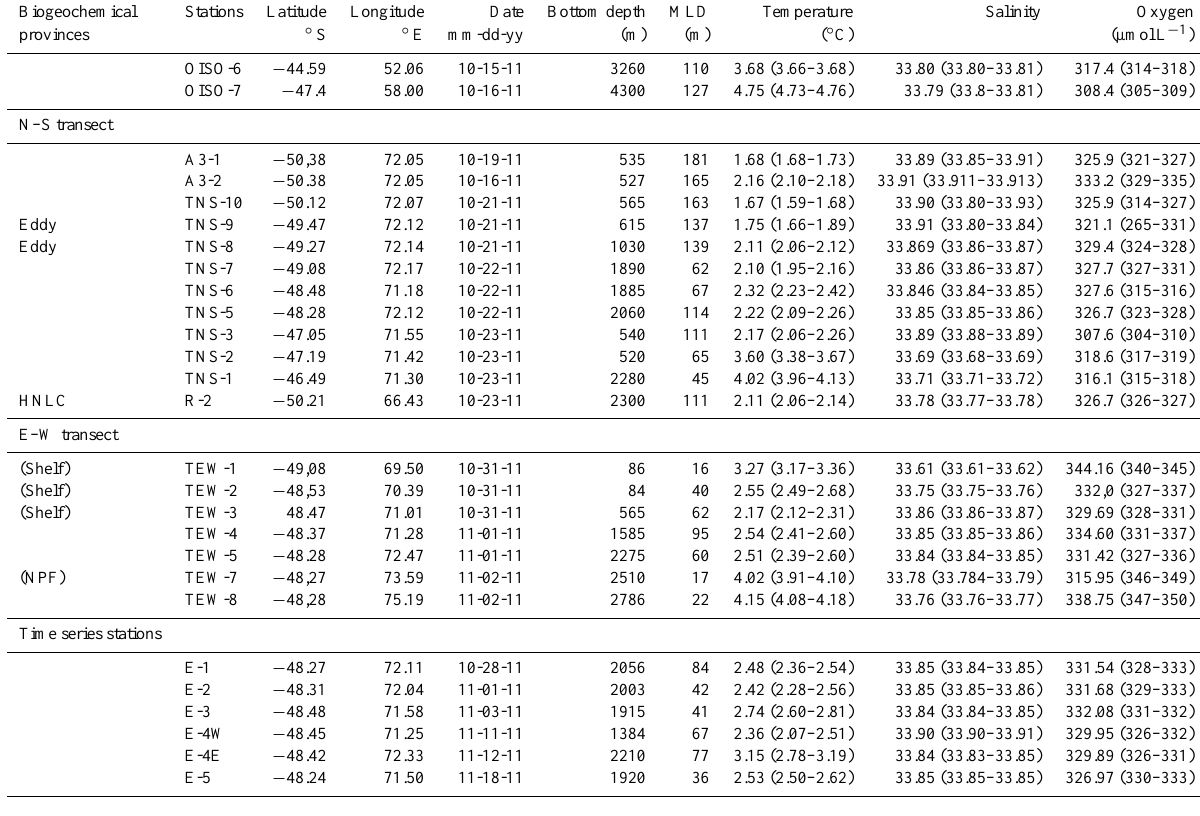
Table 1. General oceanographic features of the sampled stations during the KEOPS 2 cruise. Biogeochemical